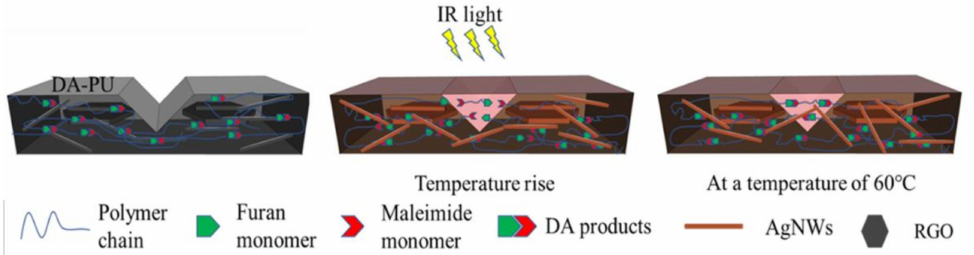
Figure 12. Schematic diagram of the self-healing of the AgNWs-RGO-DA-PU composite film under IR